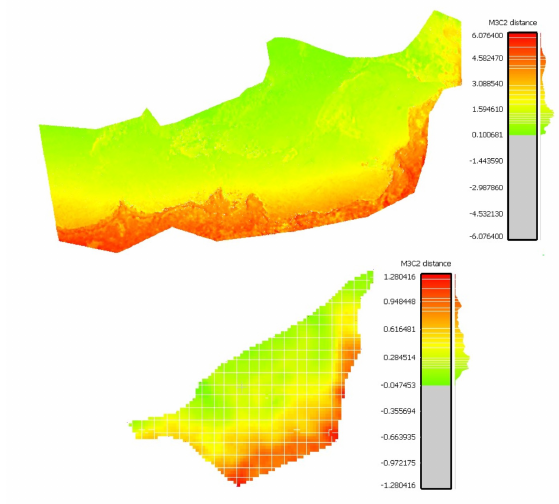
Figure 7. The initial M3C2 distances between the (reference) LiDAR point cloud and the image-based point clouds derived from the SfM-MVS. Figure 7(top) presents the M3C2 distances of Agia Napa and Figure 7(bottom) the initial distances for Amathouda test